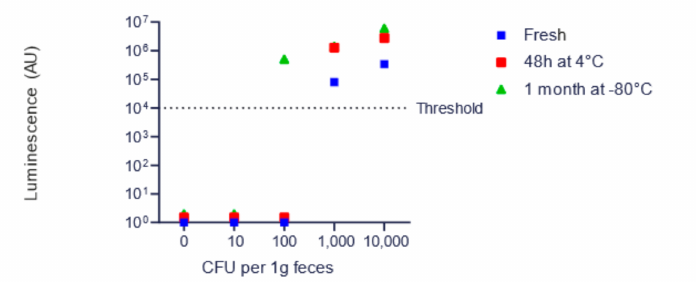
Figure 3. Limit of detection (LOD) assays. ( A ) Determination of the LOD of KP2H7 in liquid culture. Mcoc or 8M7 engineered luminescent phages were introduced into wells with 0–100 bacteria/well. Both phages successfully produced a high luminescence signal with 10 bacteria/well. Error bars represent standard error of the mean (S.E.M.) of nine independent experiments. ( B ) Luminescence detection in fecal samples spiked with KP2H7 bacteria. Fecal samples free of endogenous KP2H7 were spiked with known amounts of KP2H7 and infected with luminescent engineered Mcoc phage, followed by the detection of luminescence intensity. An amount of 100 bacteria in 100 mg feces was sufficient to produce a positive luminescence signal after phage infection. The trendline indicates the median results for each sample set. ( C ) Luminescence detection in fecal samples spiked with KP2H7 and stored under different conditions. Fecal samples that were spiked with defined amounts of KP2H7 bacteria were either stored at 4 ◦ C for 48 h, − 80 ◦ C for one month, or examined when fresh. Mcoc engineered luminescent phages were then introduced to the samples and the luminescence signal was measured. Under all different storage conditions, 100 bacteria per 100 mg of feces was sufficient to produce a positive